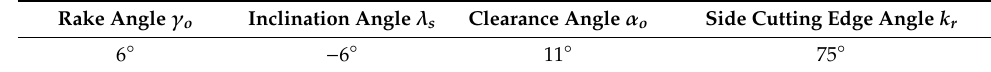
Table 2. Geometric parameters of the